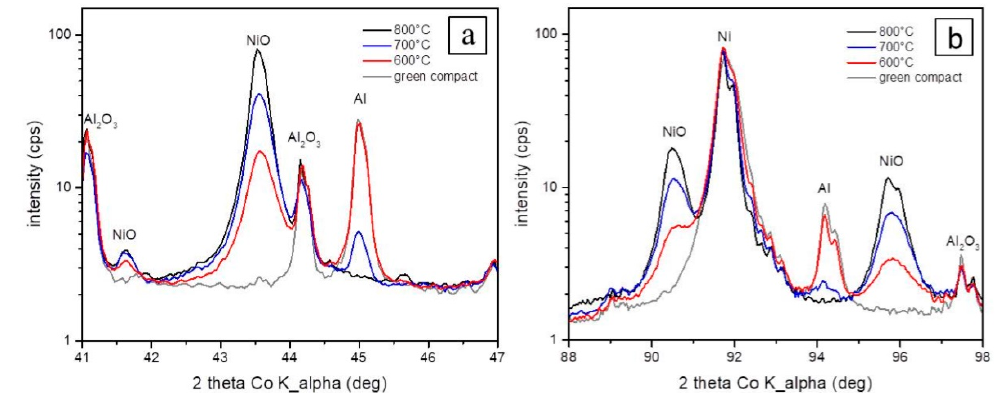
Figure 8. Selected parts of the X-ray diffraction patterns shown in Figure 8 show the evolution of NiO ( a ), Ni, and Al and the Al 2 O 3 ( b ) stability with processing temperature.